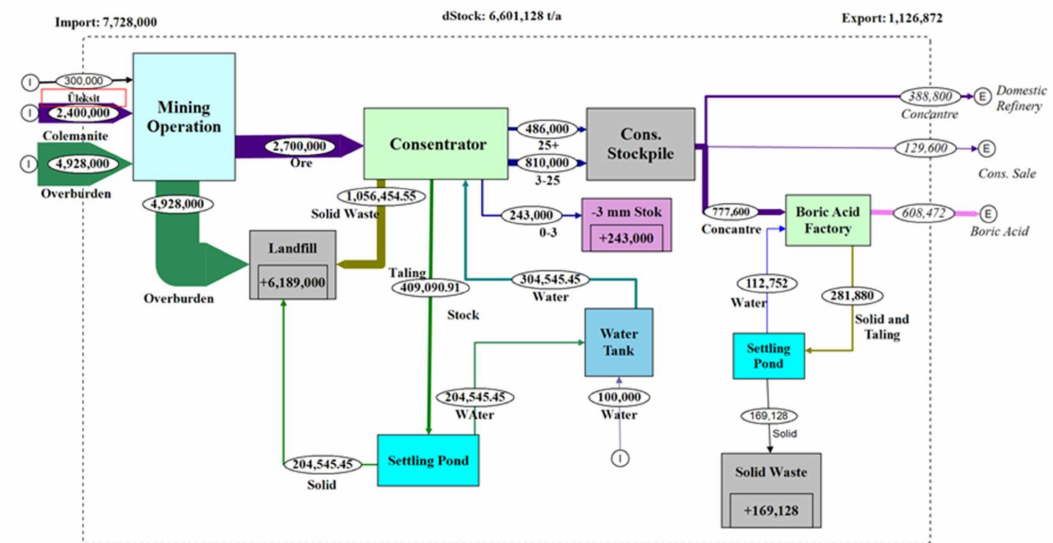
Figure 10. Colemanite ore MFA model and respective flows are shown in the Sankey diagram.